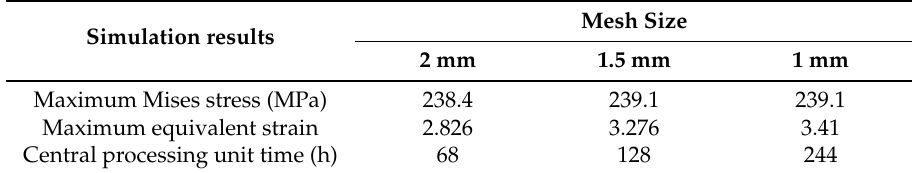
Figure 5. The finite element model for forward tube spinning. Table 5. Simulation results under different mesh sizes.